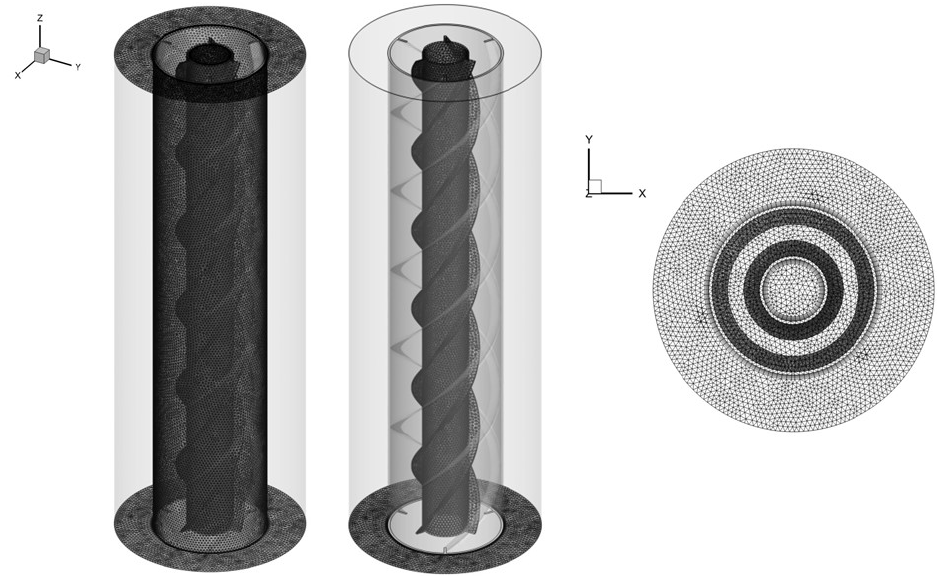
Figure 2. The configuration of the mesh after grid independence analysis.